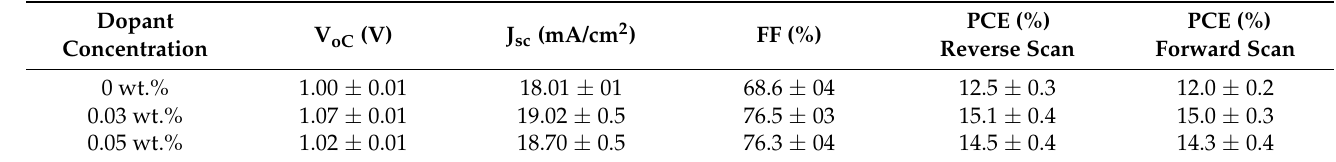
Figure 4. ( a ) Device structure of the inverted PSCs employing PEDOT:PSS (pristine or MXene- doped) as an HTL and PC 61 BM as an ETL. ( b ) J–V curves of PEDOT:PSS, 0.03 wt.% Ti 3 C 2 T x -doped PEDOT:PSS, and 0.05 wt.% Ti 3 C 2 T x -doped PEDOT:PSS devices under different scan directions. ( c ) Incident photon conversion efficiency (IPCE) spectra and integrated J sc for different doping concentrations of Ti 3 C 2 T x . ( d ) UPS spectra for pure PEDOT:PSS and Ti 3 C 2 T x -doped PEDOT:PSS. Table 5. Photovoltaic performance parameters of PSCs employing pristine PEDOT:PSS and different doping amounts of Ti 3 C 2 T x -doped PEDOT:PSS as